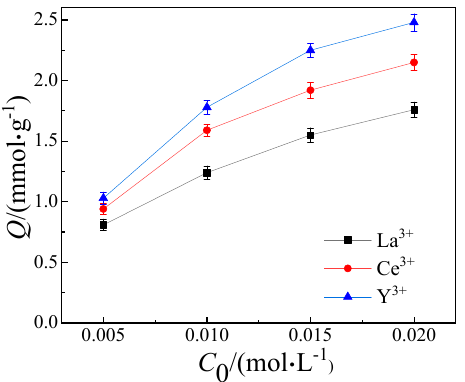
Figure 6. E ff ect of initial concentration of metal ions. ( t = 4 h; T = 40 °C; pH for La 3 + , Ce 3 + and Y 3 + Figure 6. Effect of initial concentration of metal ions. ( t = 4 h; T = 40 ℃ ; pH for La 3+ , Ce 3+ and Y 3+ were 2.0, were 2.0, 1.0 and 3.0 respectively). 1.0 and 3.0 respectively).